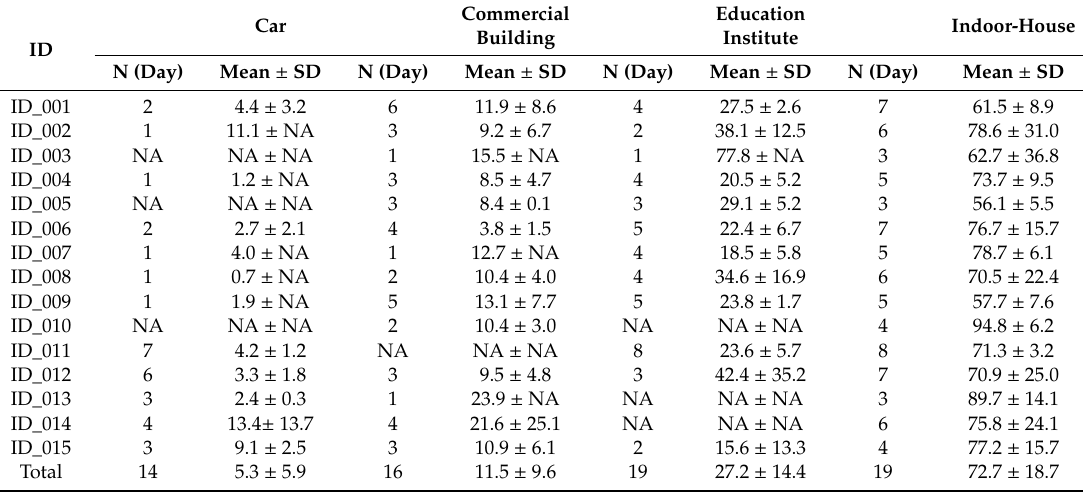
Table 2. Average time fraction (mean ± SD) that the participants spent in a day (%).